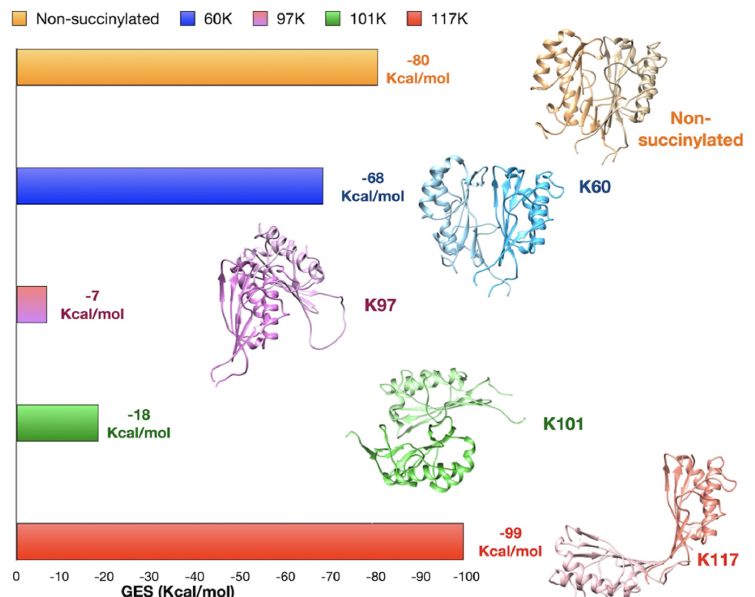
Figure 6. In silico analysis of hRIDA structure changes following K-succinylation. The global energy score (GES, Kcal/mol), calculated by the FireDock program for unsuccinylated hRIDA dimer and K60, K97, K101 or K117 succinylated hRIDA, is reported in histograms. The predicted 3D model of unsuccinylated and K-succinylated hRIDA are reported, highlighting the structural changes inferred by succinyl residue on K60, K97, K101 or K117.